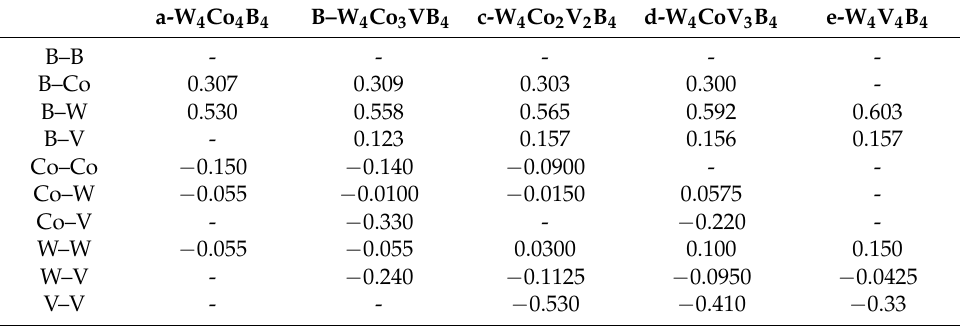
Table 4. Calculated overlap population of bonds for W 4 Co 4 − x V x B 4